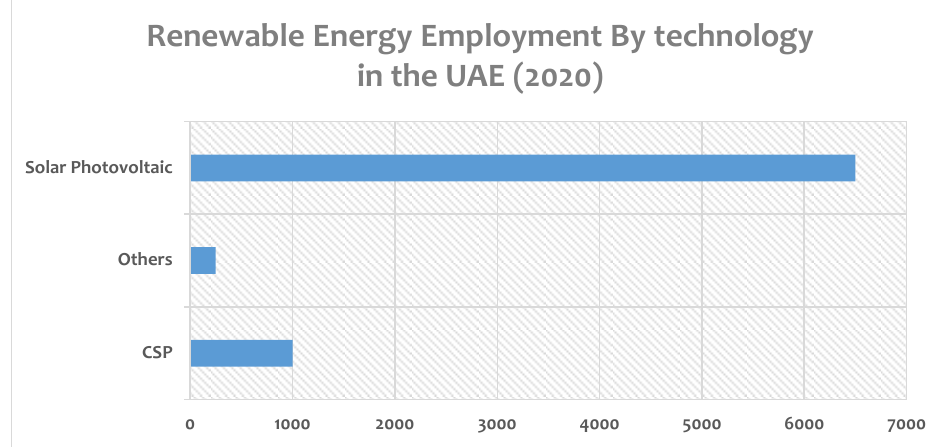
Figure 5. Renewable energy job creation in the UAE (2020). Data were collected from [45]. Figure 6 shows the declining global trends in total installation costs and average LCOE of PV and CSP. These trends help the strategies to expand solar power generation capacity in the UAE.